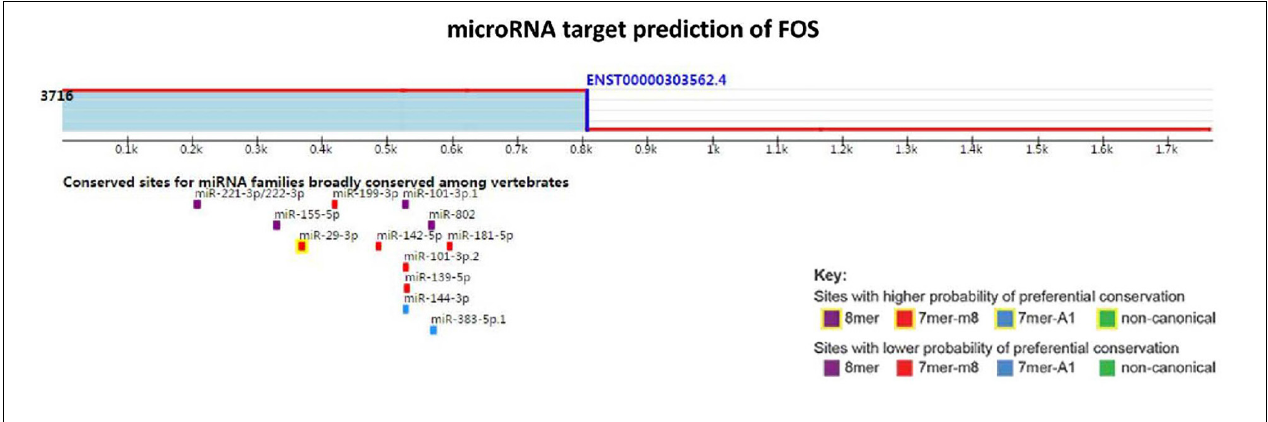
FIGURE 8 | MicroRNA target prediction of FOS.